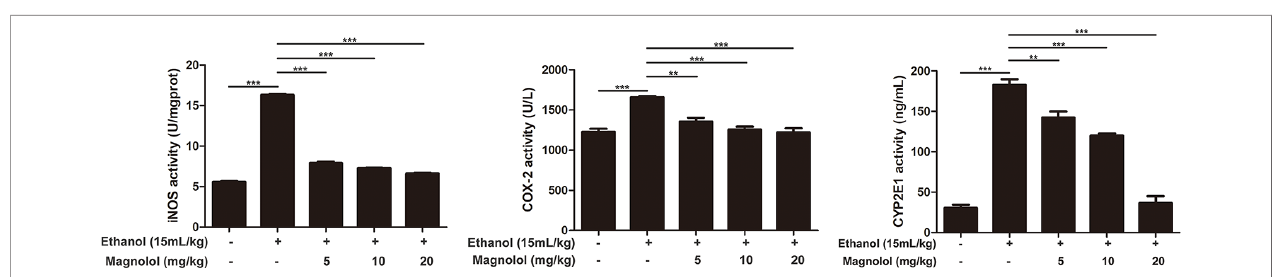
FIGURE 5 | Effects of magnolol on mice alcohol-induced liver damage in iNOS, Cox-2, and CYP2E1 at the enzyme level. iNOS, Cox-2, and CYP2E1 were examined by enzyme activity test. The data is presented as mean ± SD. (**P < 0.01, ***P <